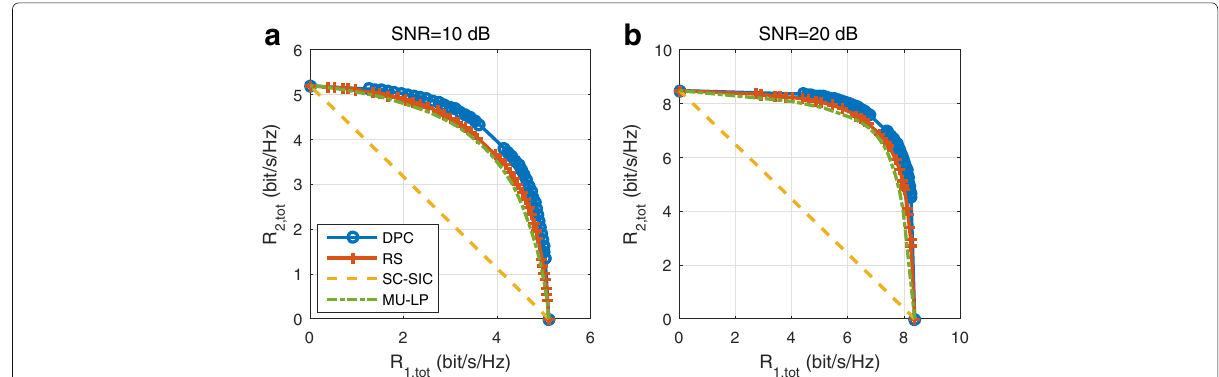
Fig. 5 Achievable rate region comparison of different strategies in underloaded two-user deployment with perfect CSIT, averaged over 100 random channel realizations, σ 2 1 = 1, σ 2 2 = 1, and N t = 4. a SNR = 10 dB. b SNR = 20